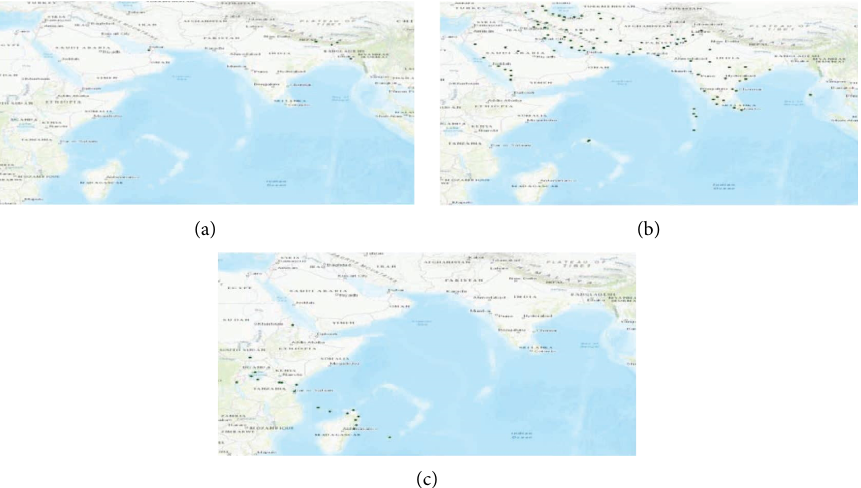
Figure 10: LCC of the Africa-Middle East-Southern Asia component after isolation from the network. Te green dots are the remaining airports after attacks on the world air transportation network (a) strength attack, (b) weighted betweenness attack, and (c) weighted PageRank attack. Te LCC isolated by the strength attack covers fve countries (Nepal, Bhutan, the United Arab Emirates, India, and Bangladesh). Te LCC isolated by the weighted PageRank attack covers East Africa and Madagascar countries. Te LCC separated by the weighted betweenness attack covers mainly the Middle East and Southern Asia